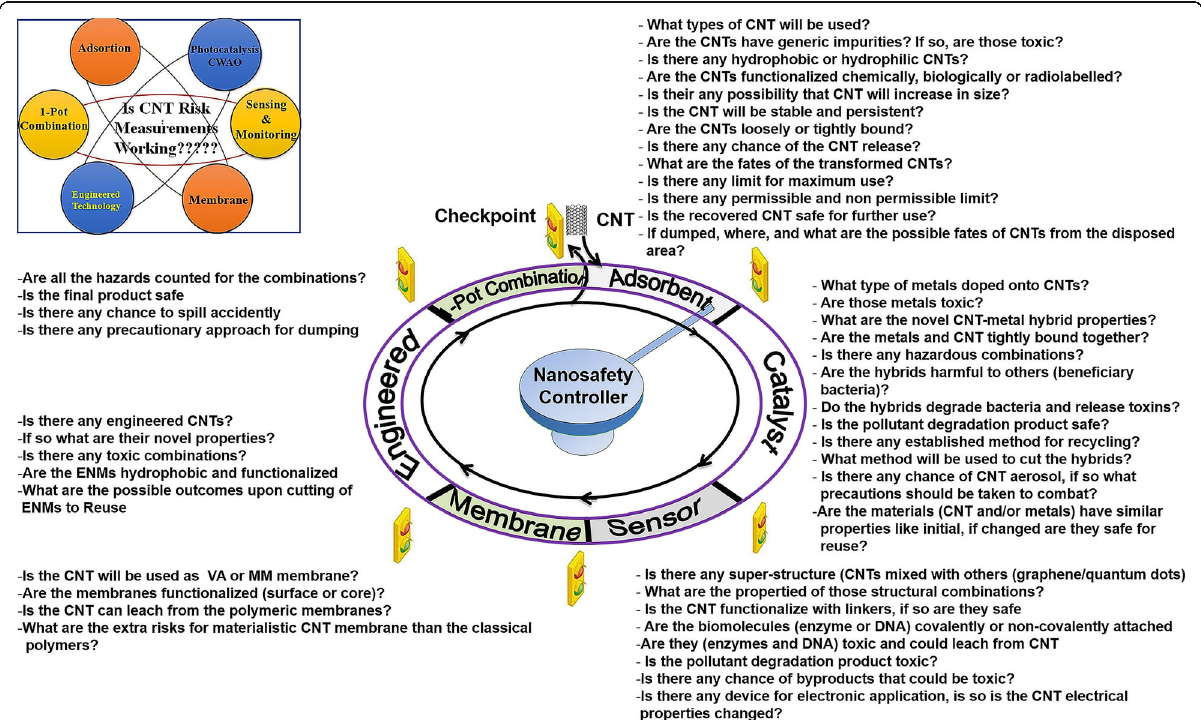
Fig. 1 Nanosafety clock. Clockwise rotation pertains to major CNT risk measurements in water purification. These major risks are